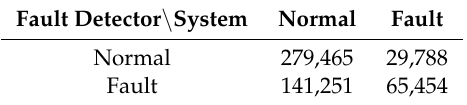
Table 6. Confusion matrix for fault detection, based on double-diode Model and an adaptive threshold.